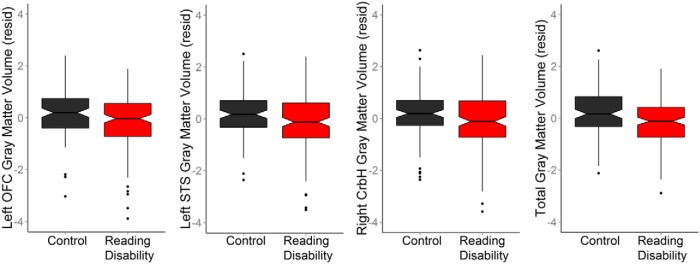
Reading disability group differences in gray matter within meta-analysis ROI (n = 255). Significantly lower gray matter volume [adjusted for age, age2, gender, and site (resid)] was observed in reading disability cases compared to controls within left OFC (including pars orbitalis), and left STS. There were not significant reading disability group differences in right cerebellar hemisphere (CrbH) ROI gray matter volume, perhaps because of the increased gray matter volume variance in the reading disability group. The ROI group differences in gray matter volume were statistically dependent on total gray matter volume.